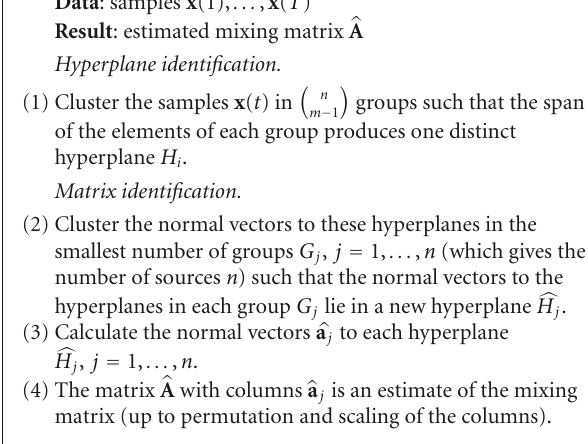
Algorithm 2: SCA source identification